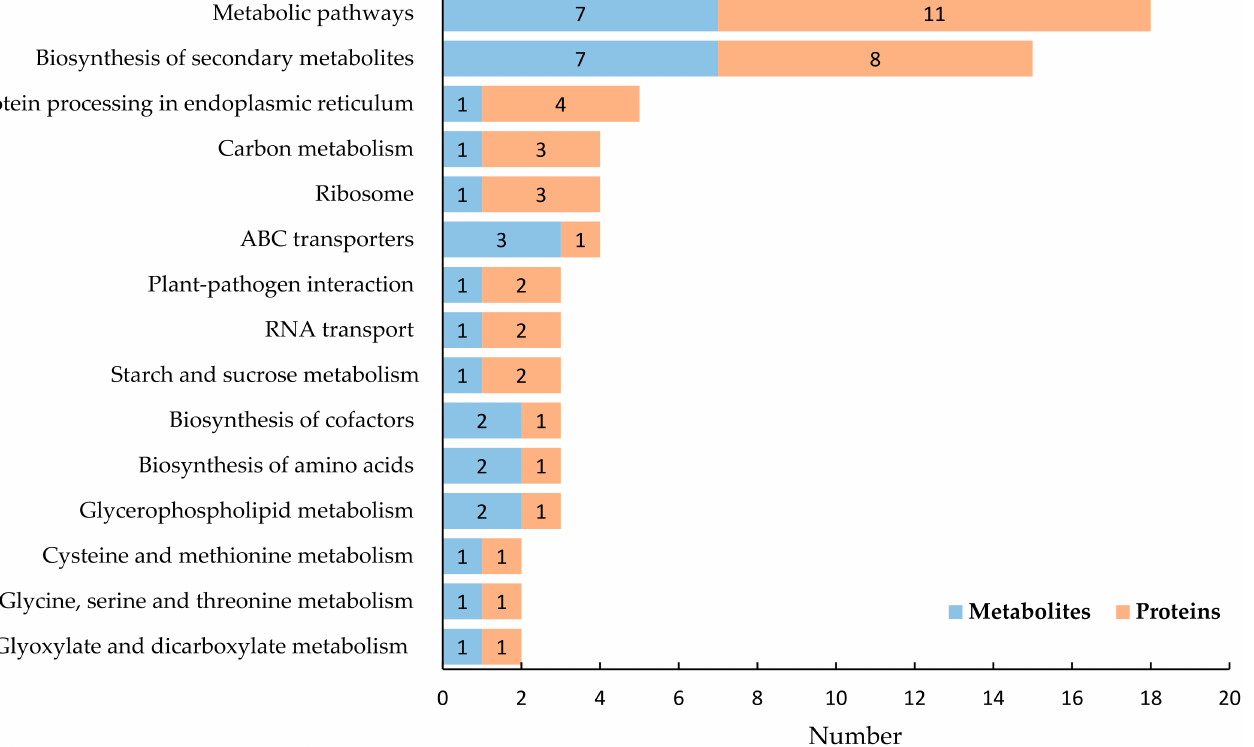
Figure 7. The KEGG pathways involving both the DEPs and DEMs in soybean nodules tissue. Orange indicates the number of DEPs involved, and blue indicates the number of DEMs.